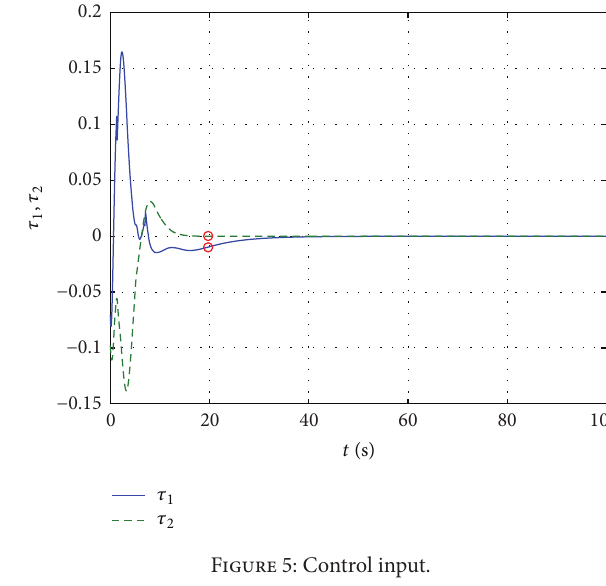
Figure 5: Control input.